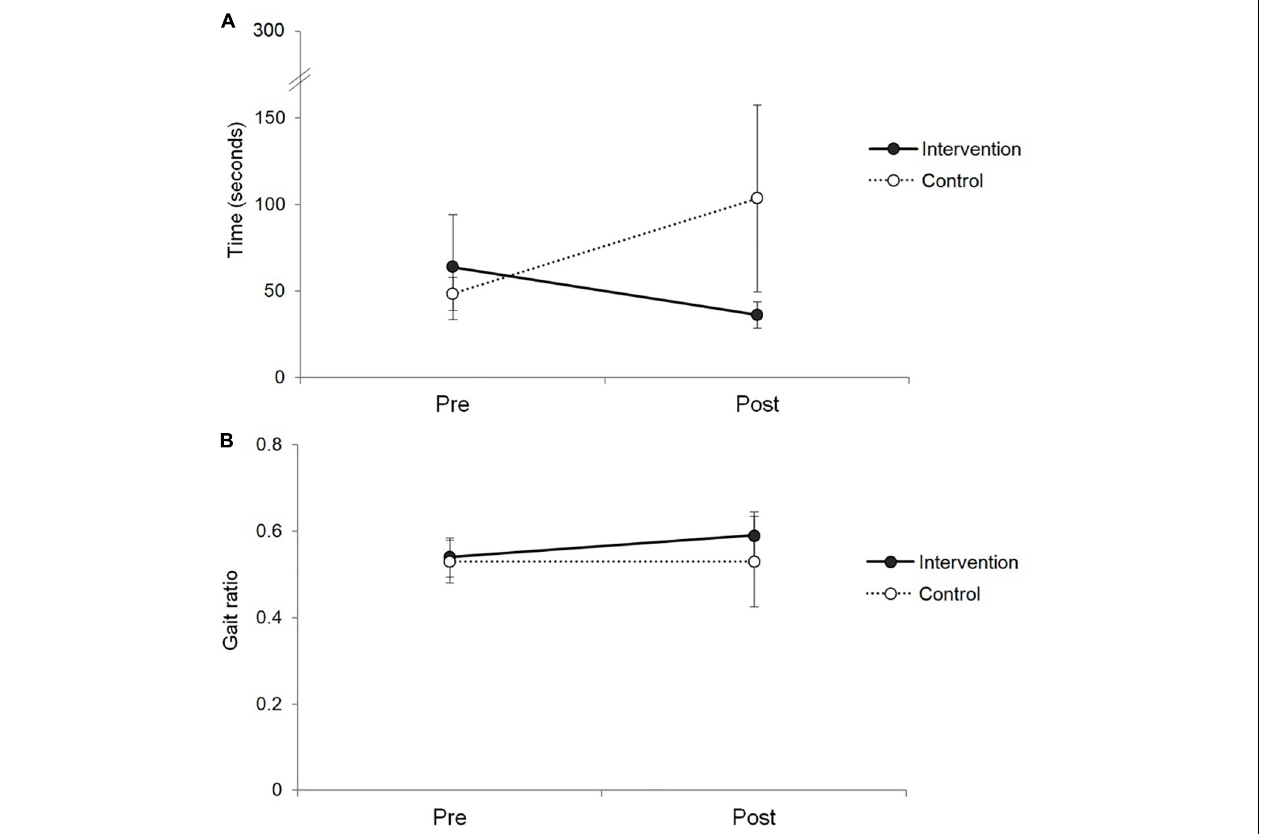
FIGURE 1 | Changes in TMT-B and gait ratio measures in the intervention and control groups. Panel A shows the changes in time to complete the TMT-B test, and panel B shows the changes in gait ratio measures.